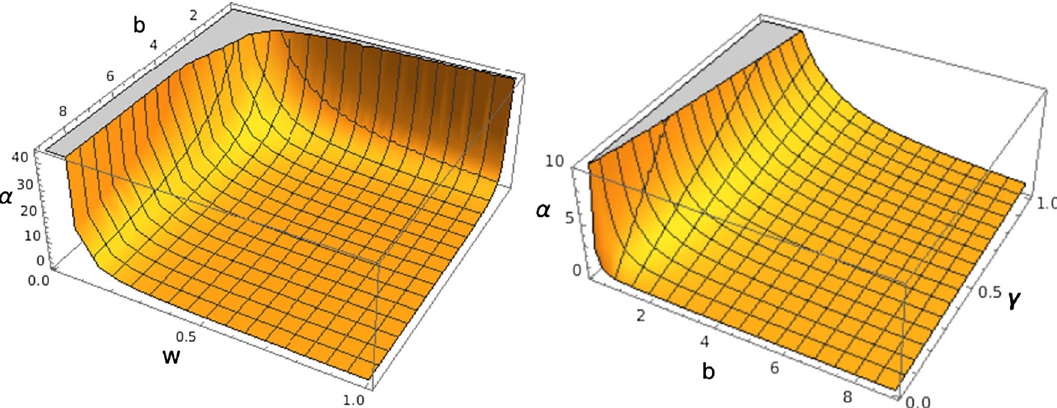
Fig. 1 In the left panel we have plotted the deflection angle as a function of b and γ when w = 0 . 5, m = a = 1, and in the right panel same thing plotted as a function of b and w for γ = 0 . 5, m = a =